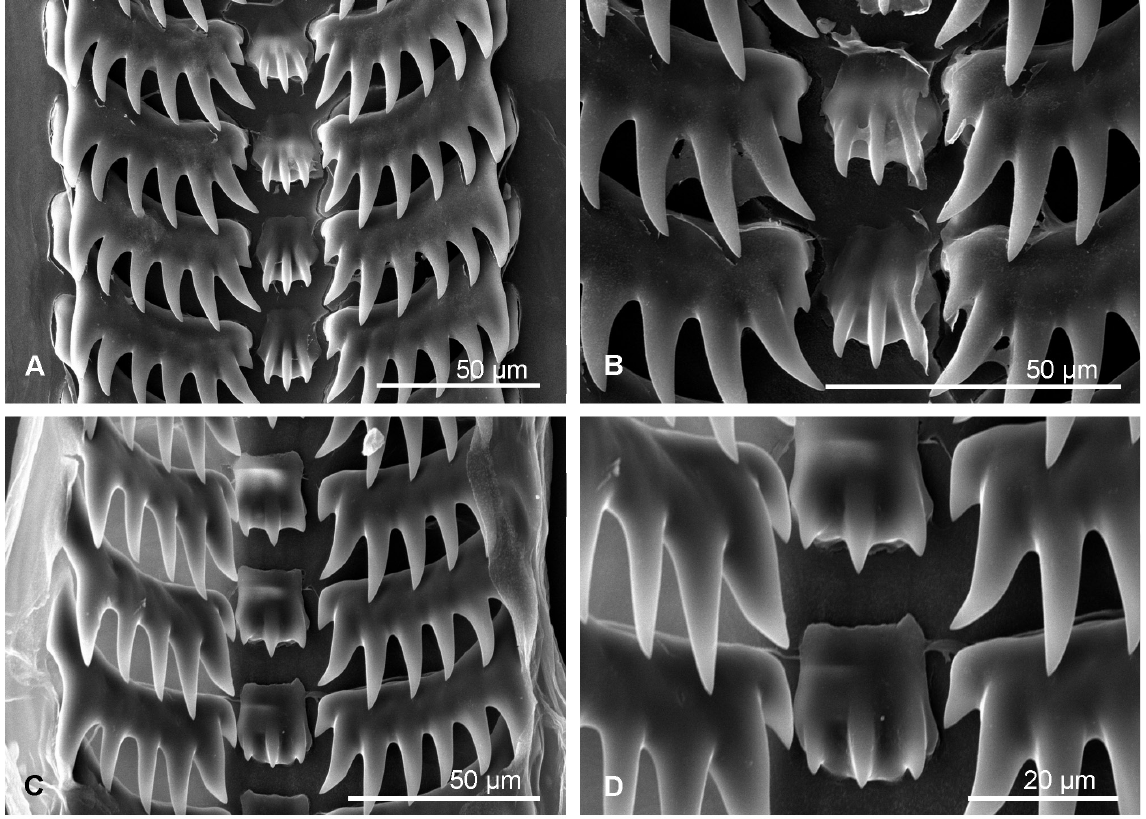
Fig. 12. Radulae of species of Vermeijius gen. nov. A–B . Vermeijius pallidus (Kuroda & Habe, 1961) gen. et comb. nov., New Caledonia, CONCALIS, stn CP2962, Grand Passage, 18°59 ′ S, 163°08 ′ E, 580– 647 m, shell, see Fig. 11D (MNHN IM-2007-35093). C–D . Vermeijius virginiae (Hadorn & Fraussen, 2002) gen. et comb. nov., South Madagascar, ATIMO VATAE, stn CP3585, 25°32 ′ S, 44°16 ′ E, 549– 576 m (MNHN